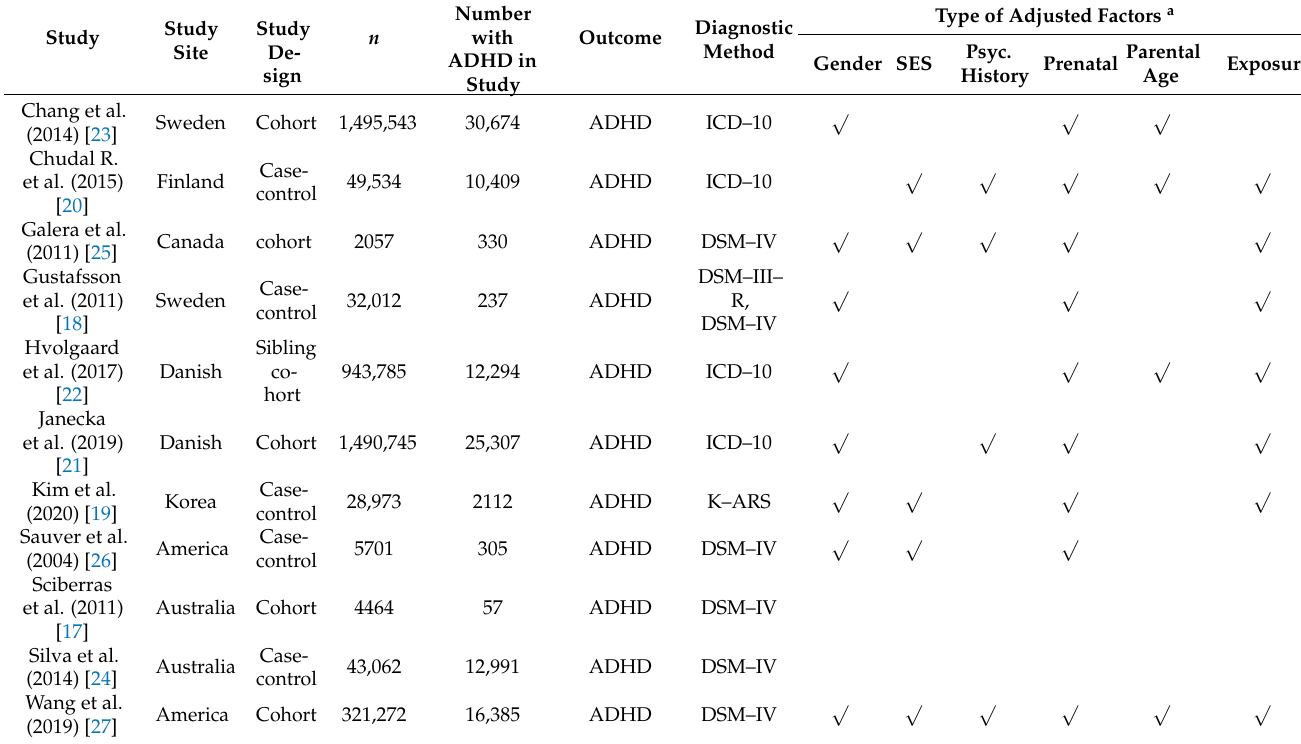
Table 1. Characteristics of included